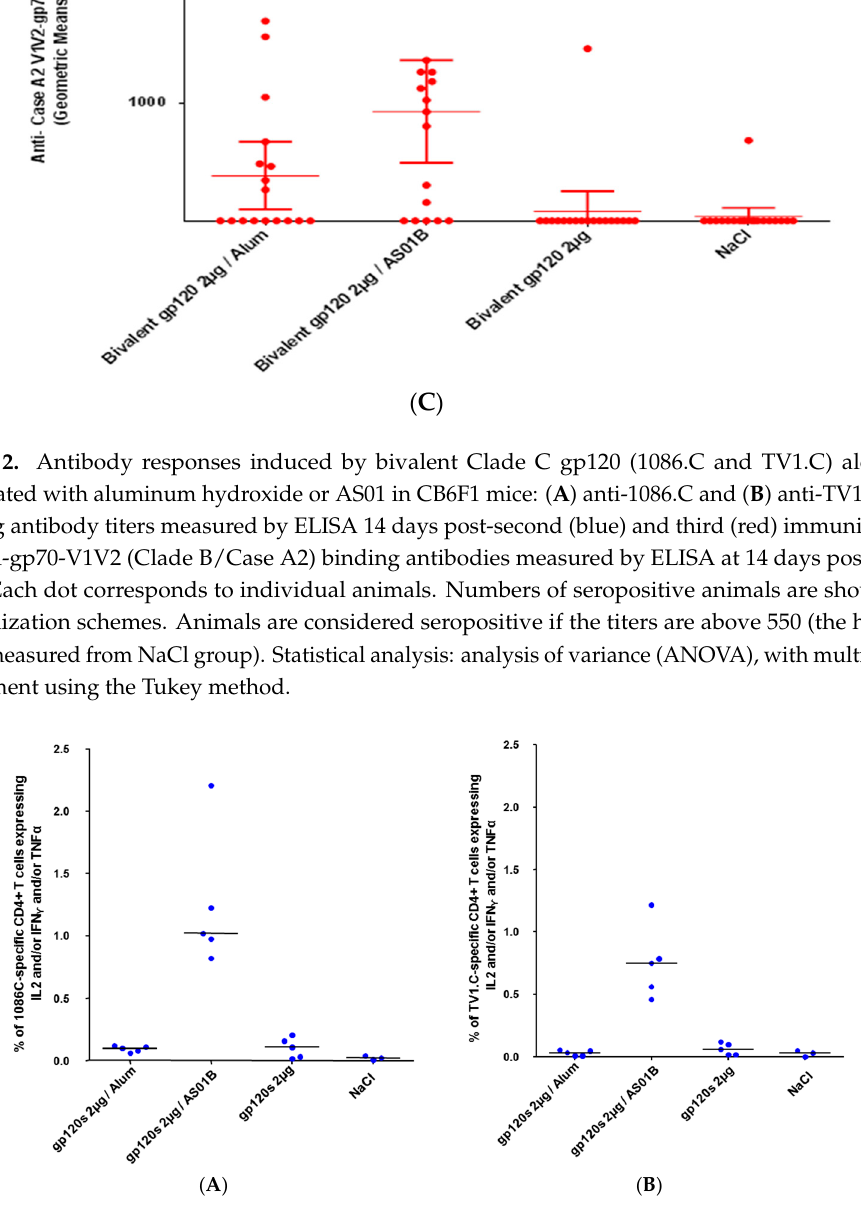
Figure 3. CD4+ T cell responses induced by bivalent Clade C gp120 (1086.C and TV1.C) alone or formulated with Aluminum hydroxide or AS01 in CB6F1 mice. ( A ) 1086.C- and ( B ) TV1.C-specific CD4+ T cells secreting IFN- γ and/or IL-2 and/or TNF α were measured by ICS at 14 days post-third immunization. Five individual animals with medians are represented.